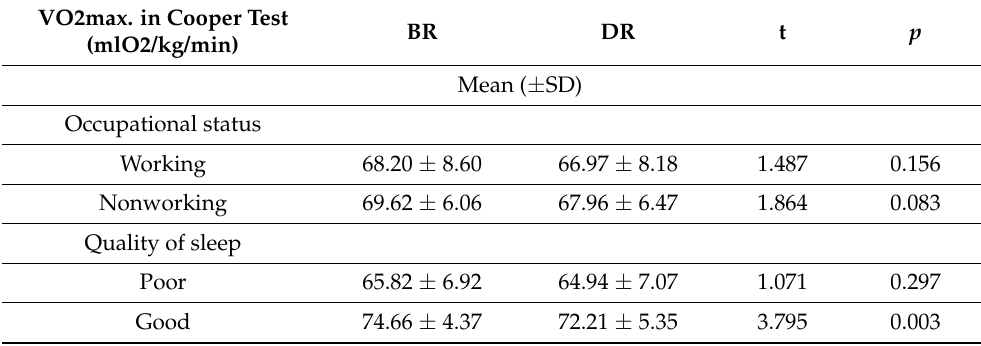
Table 5. Physical performance (mean ± SD) as estimated by the Cooper test according to the occupational status and quality of sleep. Values before (BR) and during (DR) Ramadan. VO2max. in Cooper